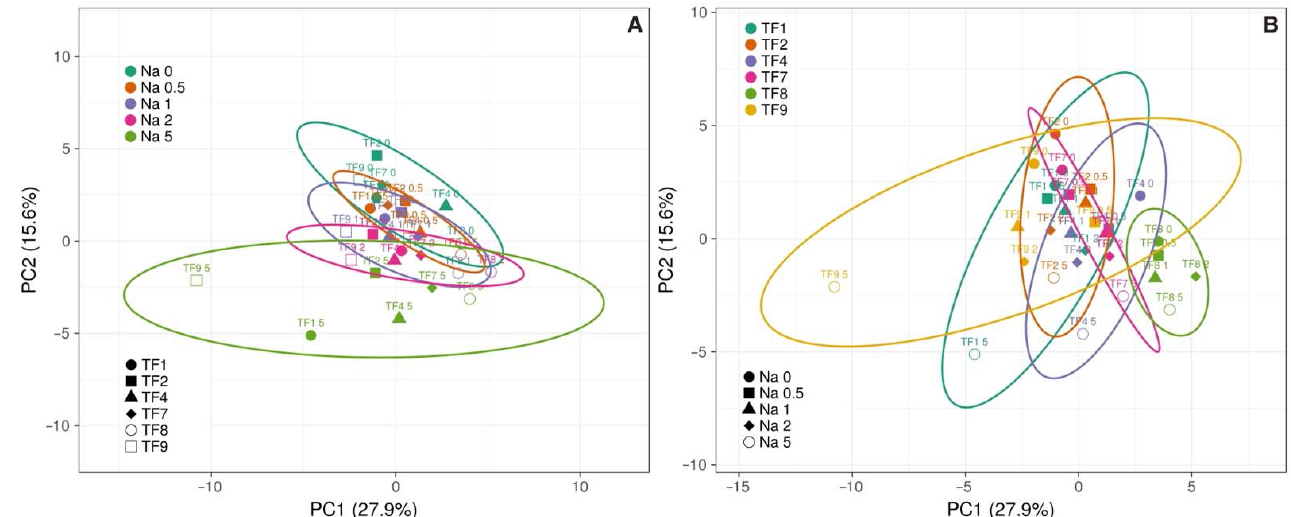
Figure 11. Principal component analysis on effect of increasing substrate salinity on mineral nutrient concentration in different parts of Trifolium fragiferum plants of different accessions. ( A ), grouping according salinity levels; ( B ), grouping according accessions. Prediction ellipses are such that with probability 0.95, a new observation from the same group will fall inside the ellipse. Unit variance scaling was applied to rows; singular value decomposition with imputation was used to calculate principal components. X and Y axes show principal component one and principal component two that explain 27.9% and 15.6% of the total variance, respectively.